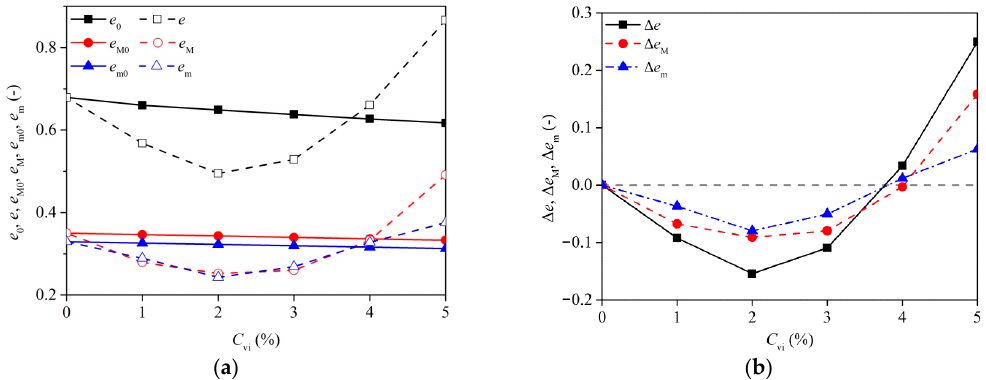
Figure 22. Macro-, micro-, and total void ratios of as-compacted and cured cement-treated GRS depending on cement content (Hollow symbol indicates a curing time of 28 d). ( a ) Initial state and after curing to 28 d; ( b ) Difference between initial and cured states.